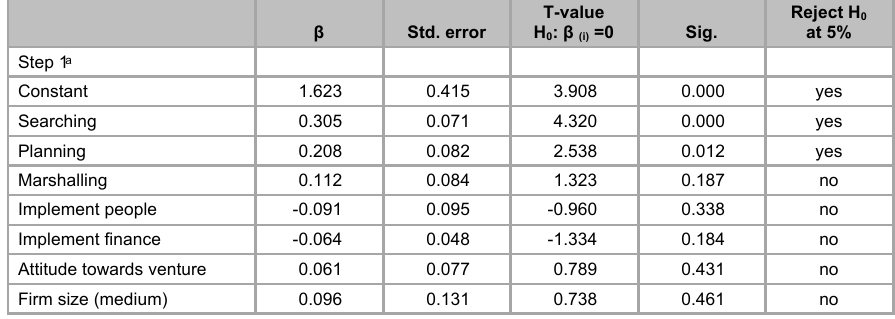
Regression results for ESE venture phases on venture competitiveness β Std.